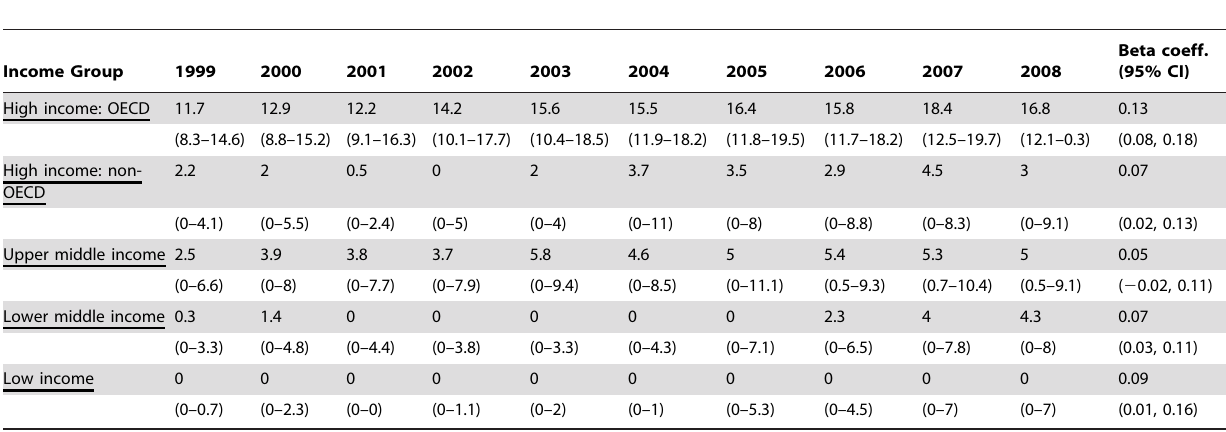
Table 3. Trends in median (interquartile range) five year running actual citation index [ACI] counts per publication, stratified by World Bank income group status